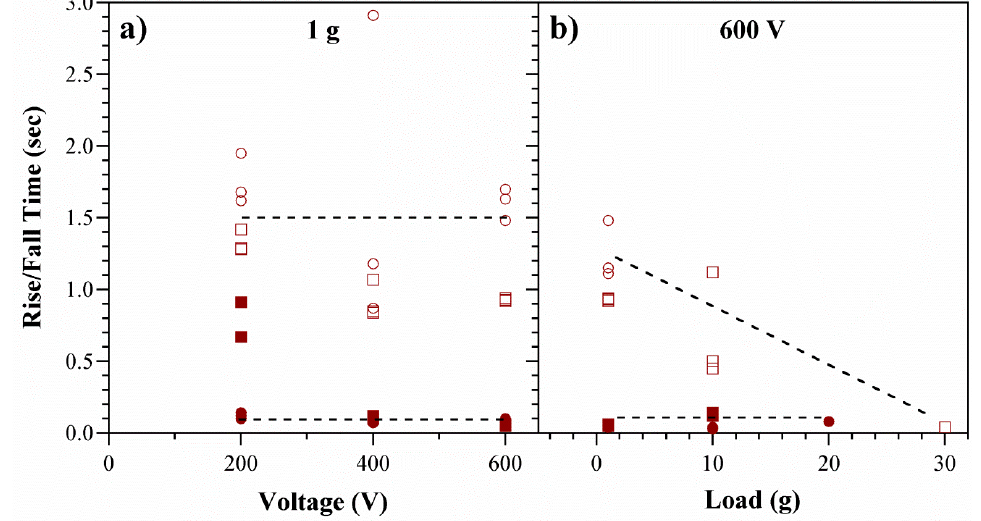
Figure 10. Rise (filled symbols) and fall (open symbols) times for two devices (1 and 2). Points represent individual on/off steps, three per device. ( a ) Times as a function of voltage under minimal load; ( b ) Times at a fixed voltage as a function of externally applied load.